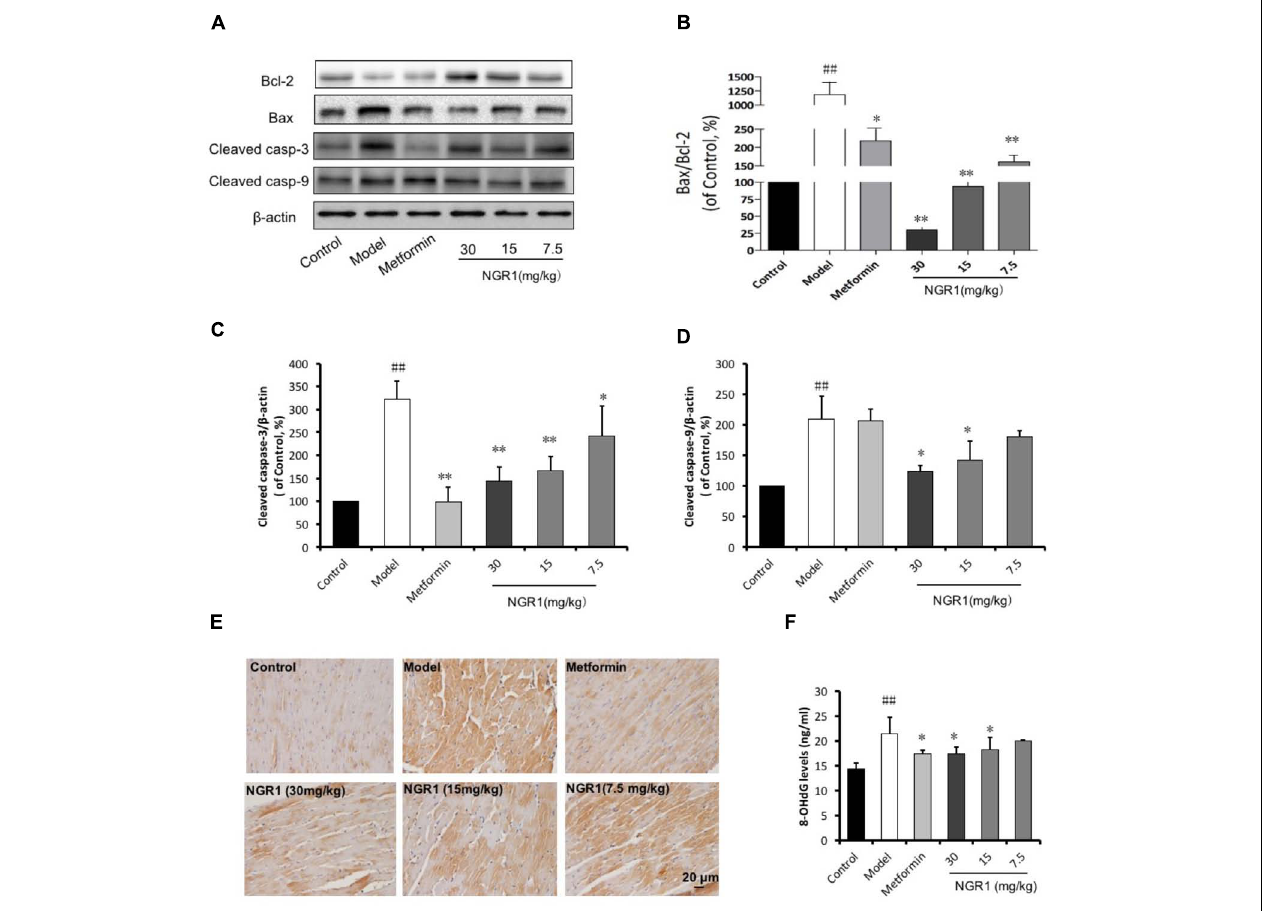
FIGURE 7 | NGR1 attenuates diabetes-induced myocardial apoptosis. (A) Representative images of apoptotic protein immunoblots and (B–D) immunoblotting results quantified in bar diagrams showing that NGR1 effectively inhibited diabetes-induced apoptosis. (E) Representative immunohistochemical images for cleaved caspase-3. The bar represents 20 µ m. (F) NGR1 inhibited DNA injury in db/db mice as indicated by decreasing 8-OHdG levels. The quantitative data are presented as the mean ± SD ( n = 3). ## P < 0.01 vs. the Control group, ∗ P < 0.05 or ∗∗ P < 0.01 vs. the Model group.